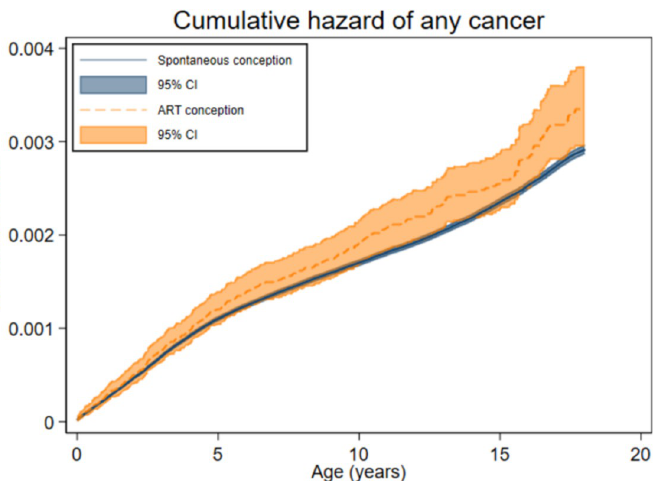
Fig 3. Cumulative hazard of first cancer (any type) up to 18 years for spontaneously and ART-conceived children born in Denmark (1994–2014), Finland (1990–2014), Norway (1984–2015), and Sweden (1985–2015). Crude hazard ratio 1.13; 95% CI 1.01 to 1.26, p = 0.03. ART, assisted reproduction technology; CI, confidence interval.